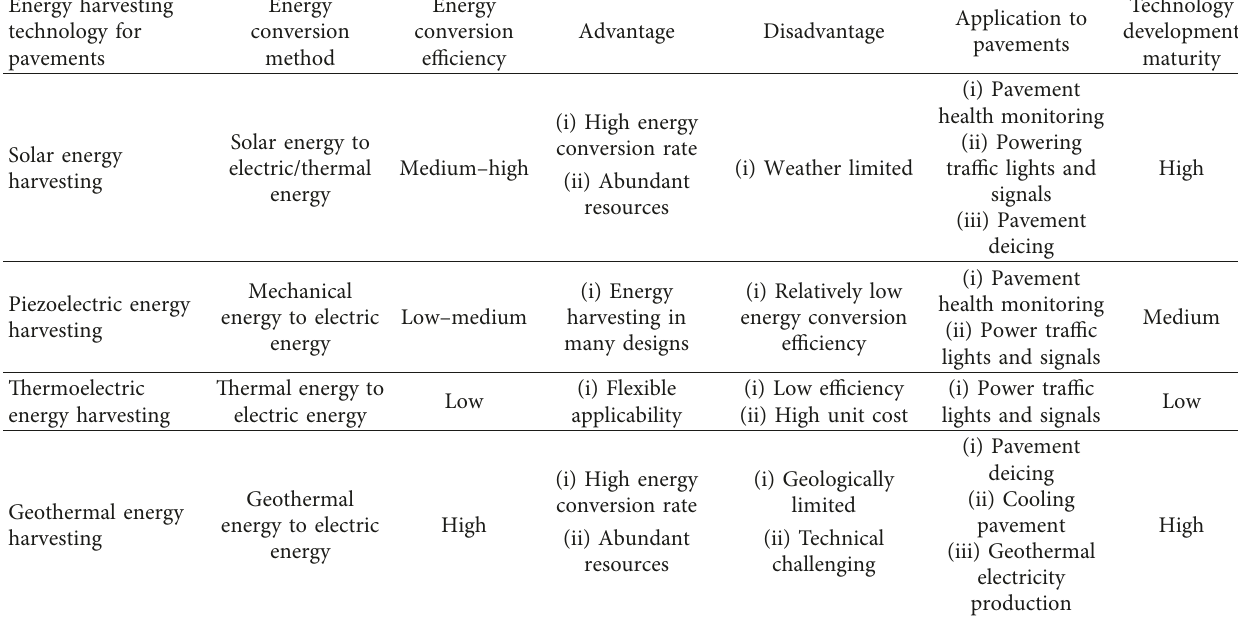
Table 4: Comparison of green technologies to harvest energy from